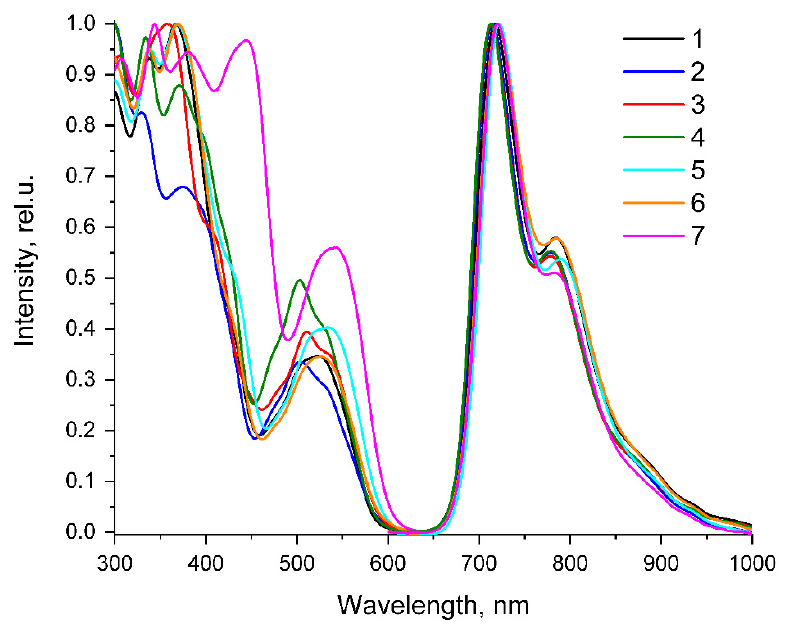
Figure 2. Excitation (left) and emission (right) spectra of complexes 1–7 in an aerated methanol solution at 298 K. Emission was excited at 365 nm; excitation spectra were recorded at 720 nm. Table 1. Photophysical data for complexes 1–7 in methanol solution, 298 K.